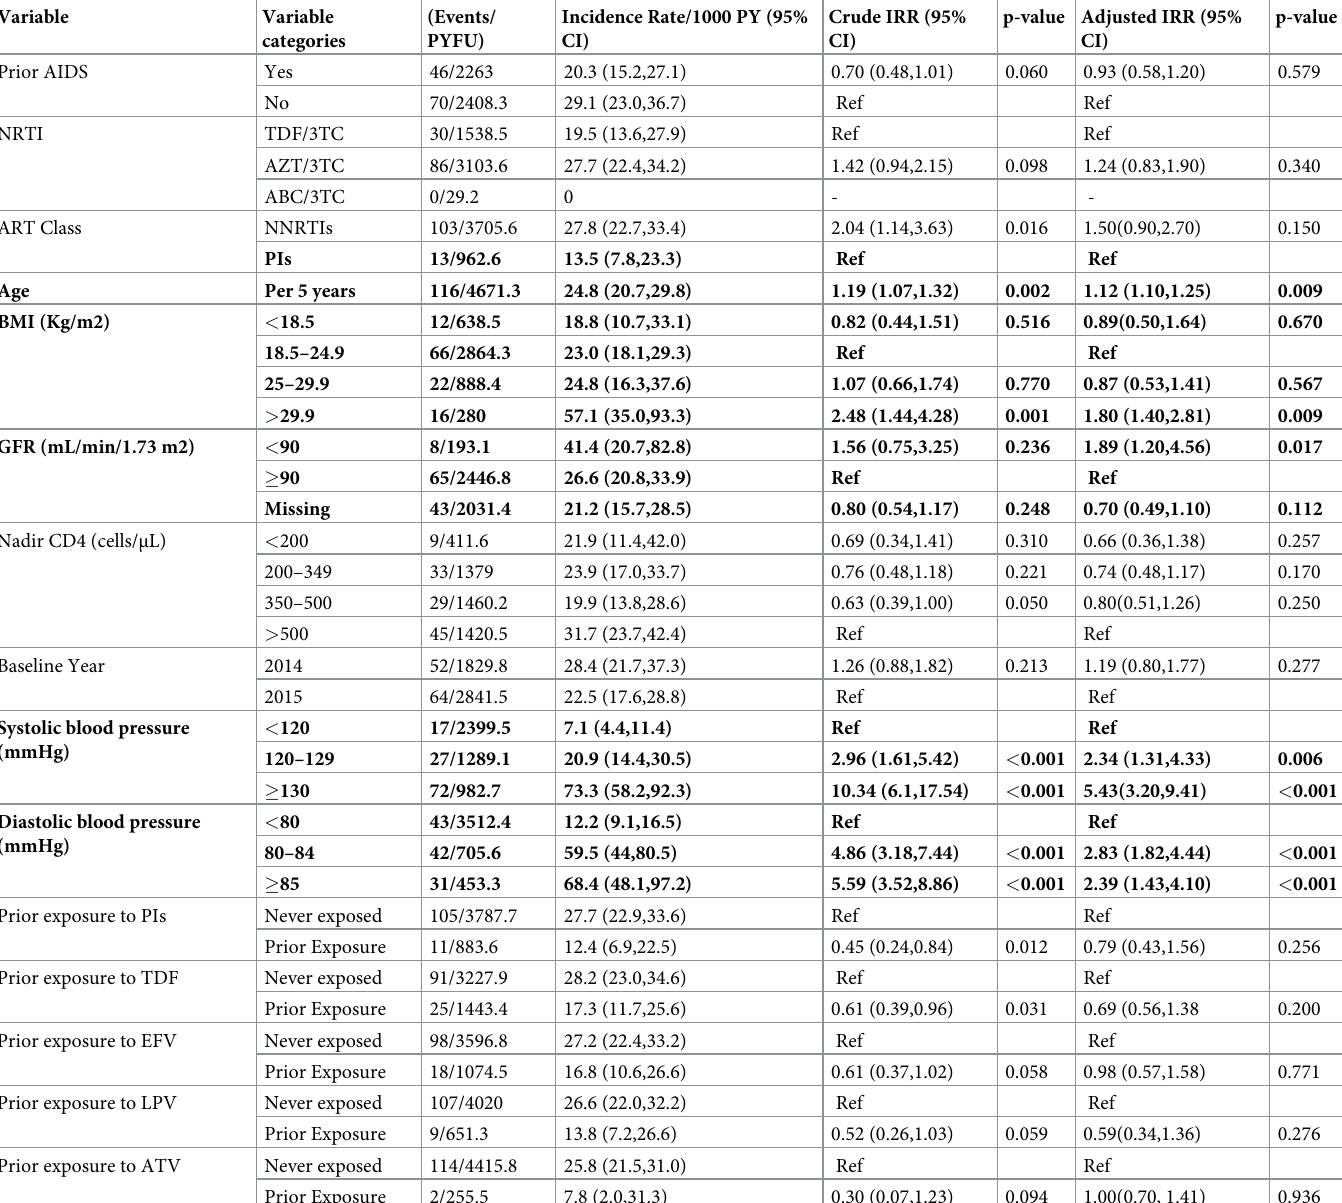
Table 4. Factors associated with of incident hypertension in the ALT cohort (n = 733).